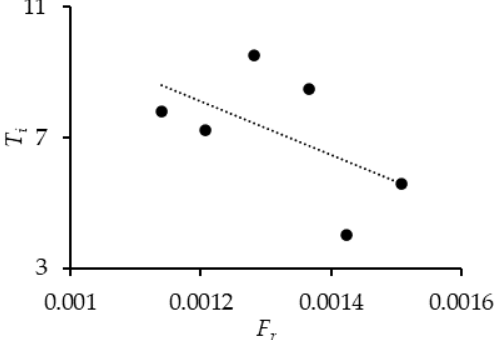
Figure 13. Relationship between Ti / h and F r with the presence of a local scour.